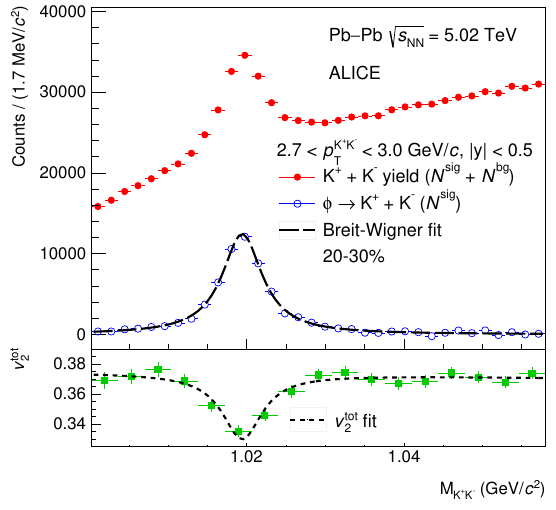
Figure 1 . (Colour online) Illustration of reconstruction and v 2 measurement for the (cid:30) -meson. The reconstruction of the (cid:30) -meson and extraction of N sig and N bg are shown in the upper panel. A (cid:12)t of eq. (2.3) to data is presented in the lower